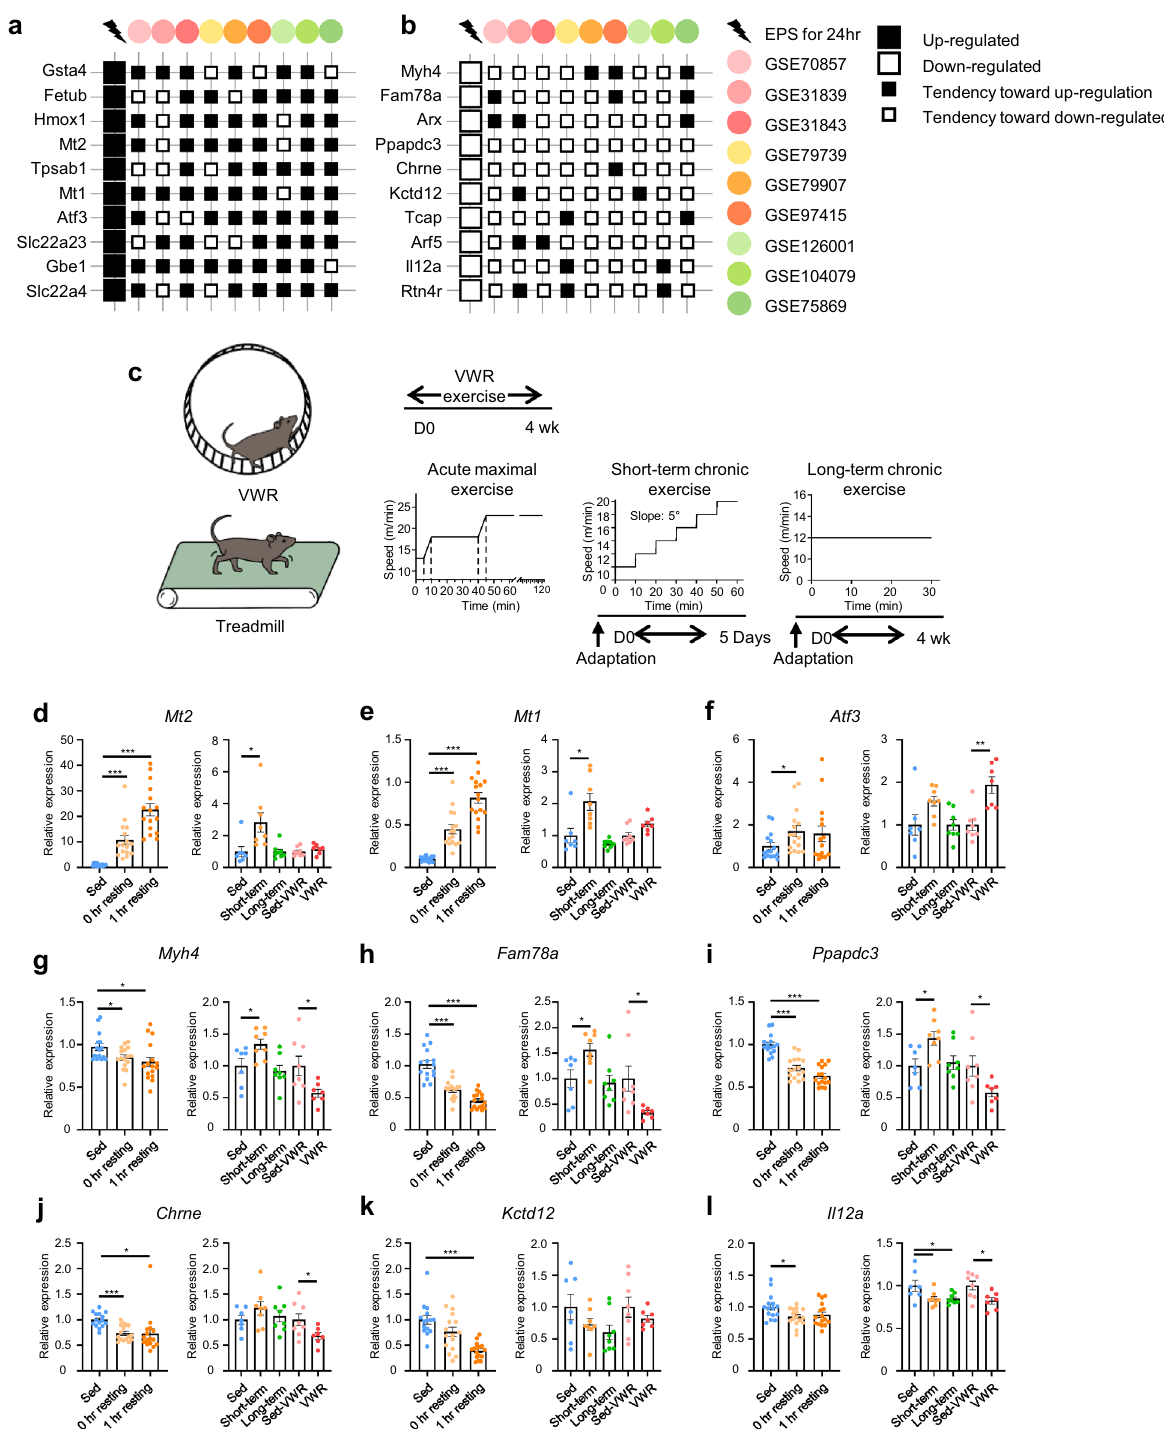
Figure 3. Expression of DEGs in exercised muscles. ( a , b ) Top 10 up- and down-regulated genes in the EPS group in the publicly available in vivo exercise datasets. Genes with log2-transformed read counts per million mapped fragments (CPM) values < 1 were excluded to enhance accuracy, and the genes were sorted according to their fold differences in expression between the two groups (control and EPS). ( c ) Exercise protocols for subsequent in vivo exercise. VWR was performed for 4 weeks ad libitum on running wheels. The acute maximal exercise was performed once until the mice were exhausted. The short-term chronic exercise was performed at a gradually increased speed for 5 days. The long-term chronic exercise was performed at the same speed for 4 weeks. ( d – l ) Mt2 , Mt1 , Aft3 , Myh4 , Fam78a , Ppapdc3 , Chrne , Kctd12 , and Il12a expression following the indicated types of exercise. For acute maximal exercise, sed (n = 15), 0 h resting (n = 16), and 1 h resting (n = 16) tibialis anterior (TA) muscles according to the resting time after exercise were analyzed. For chronic exercise, sed (n = 7), short-term (n = 8), and long-term (n = 8) gastrocnemius (GA) muscles were analyzed. For VWR exercise, sed-VWR (n = 8) and VWR (n = 7) GA muscles were analyzed. Means ± SEM; * P < 0.05, ** P < 0.01, *** P <